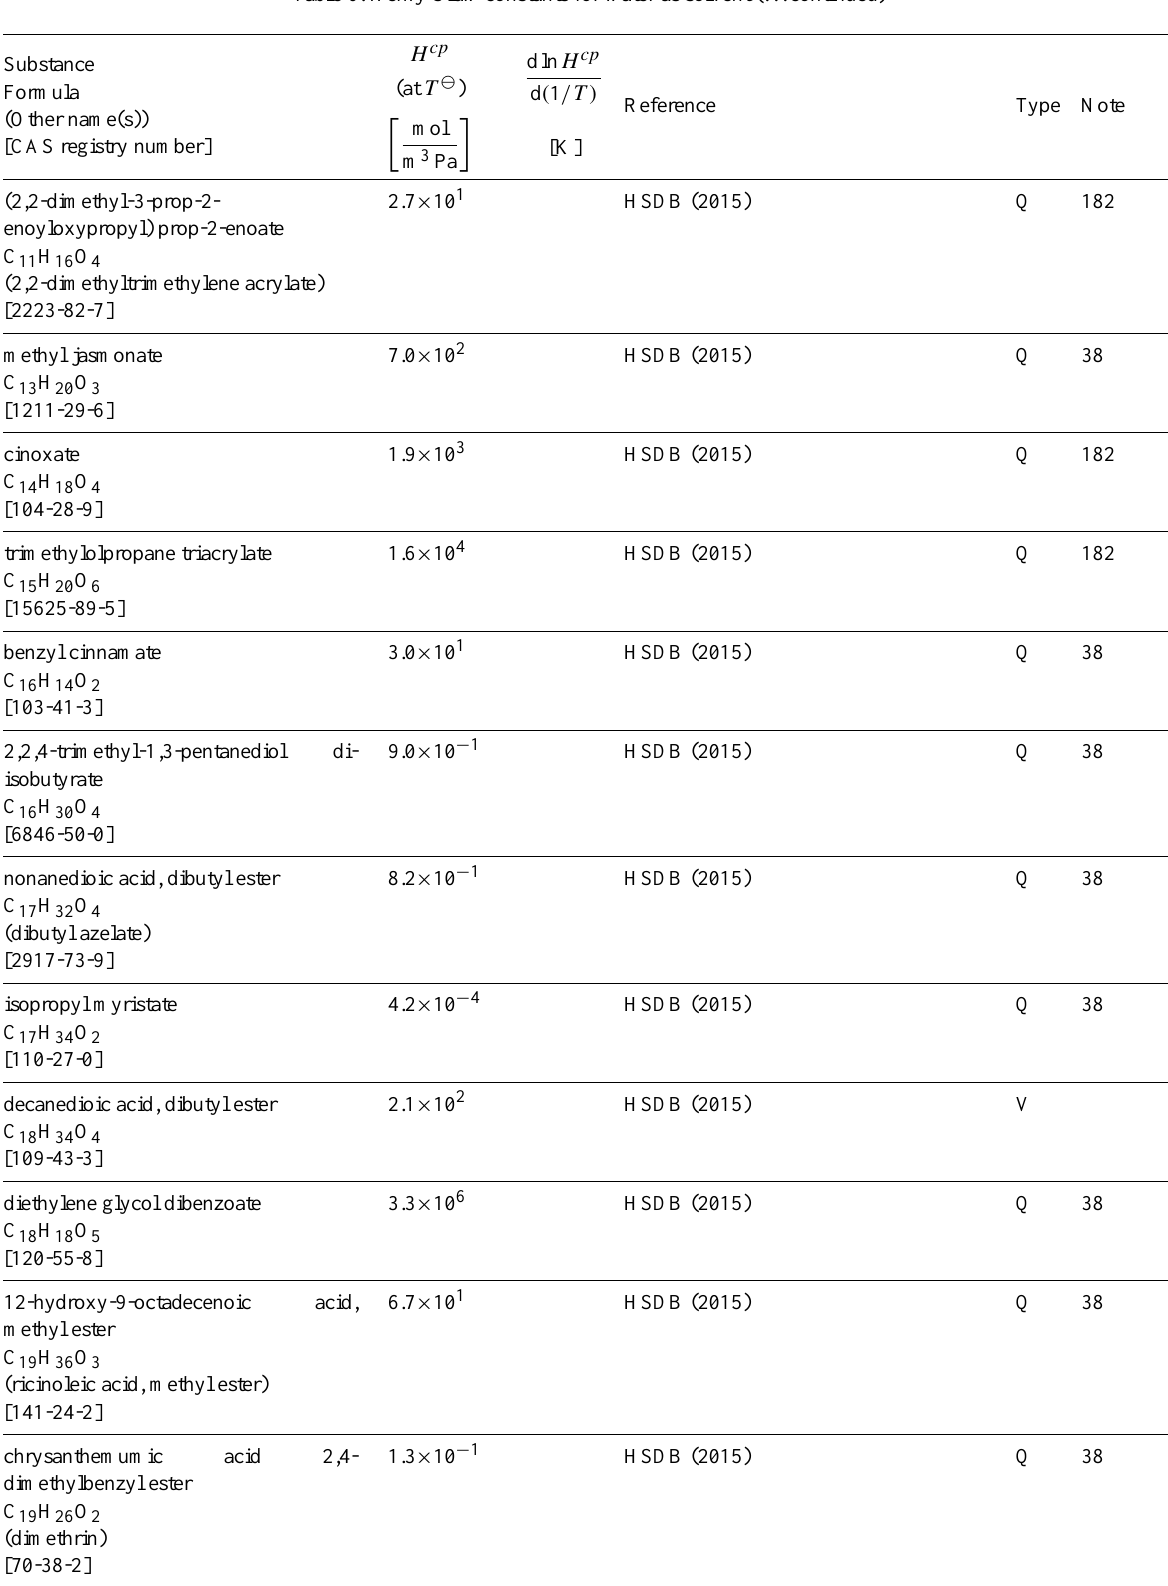
Table 6: Henry’s law constants for water as solvent